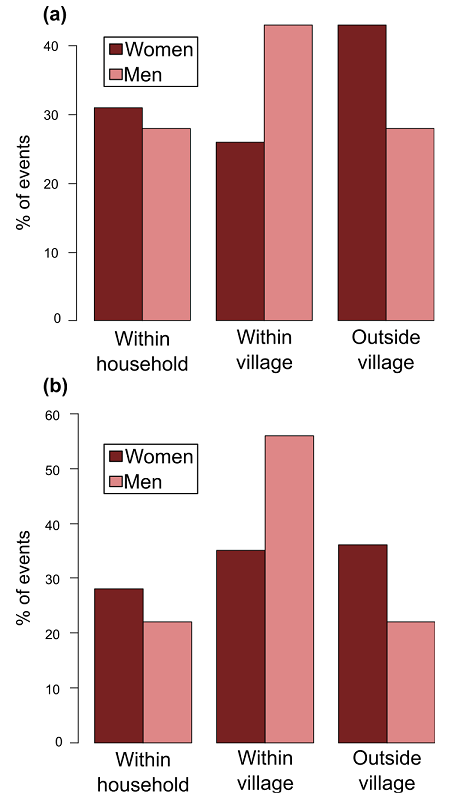
Table 4. Age of providers and recipients for intrahousehold seed transactions. Fisher’s exact test, P = 0.062. Fig. 4. Number of seed acquisition events based on gender and seed source. (a) Unraked sample (Pearson’s chi-square test, P = 0.002). (b) Raked sample (Pearson’s chi-square test, P =